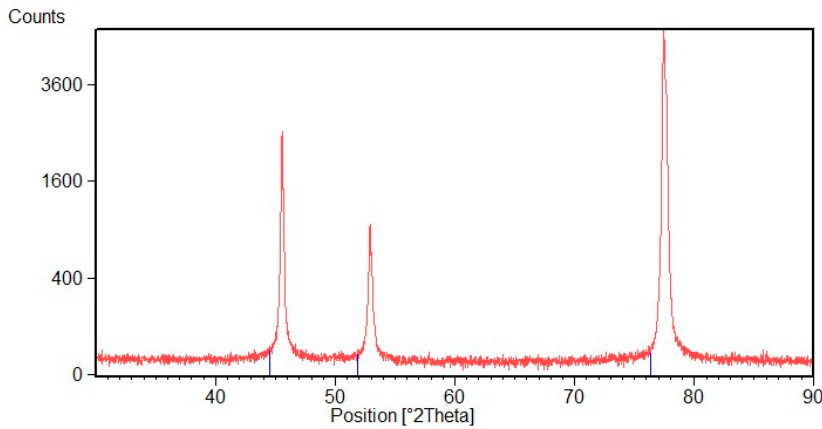
Figure 9. XRD di ff raction pa tt ern of Ni deposit.